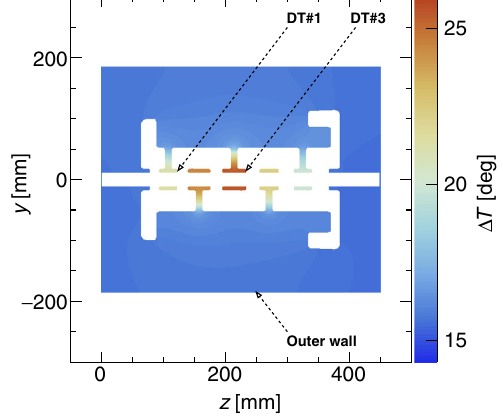
FIG. 15. Steady-state temperature distribution of the short IH with the peak power of 88 kW and a nominal duty factor. The distribution shows the temperature difference from the initial state of a uniform 24°C.